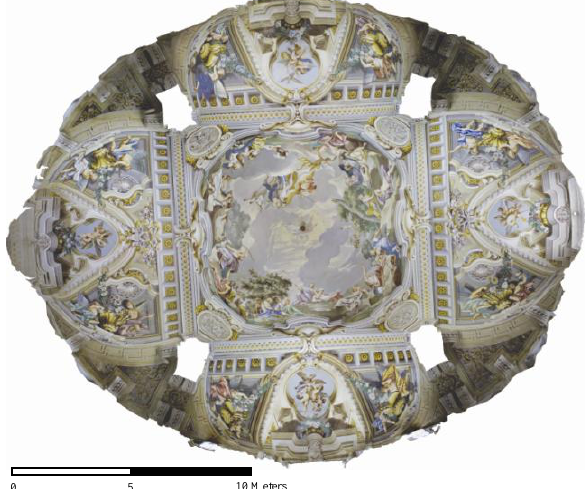
5 Figure 2 Orthophoto of the hall